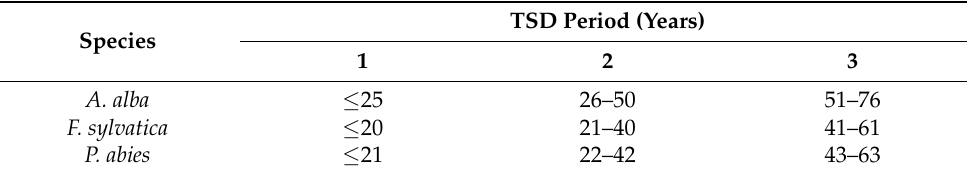
Table 1. Range of TSD periods.